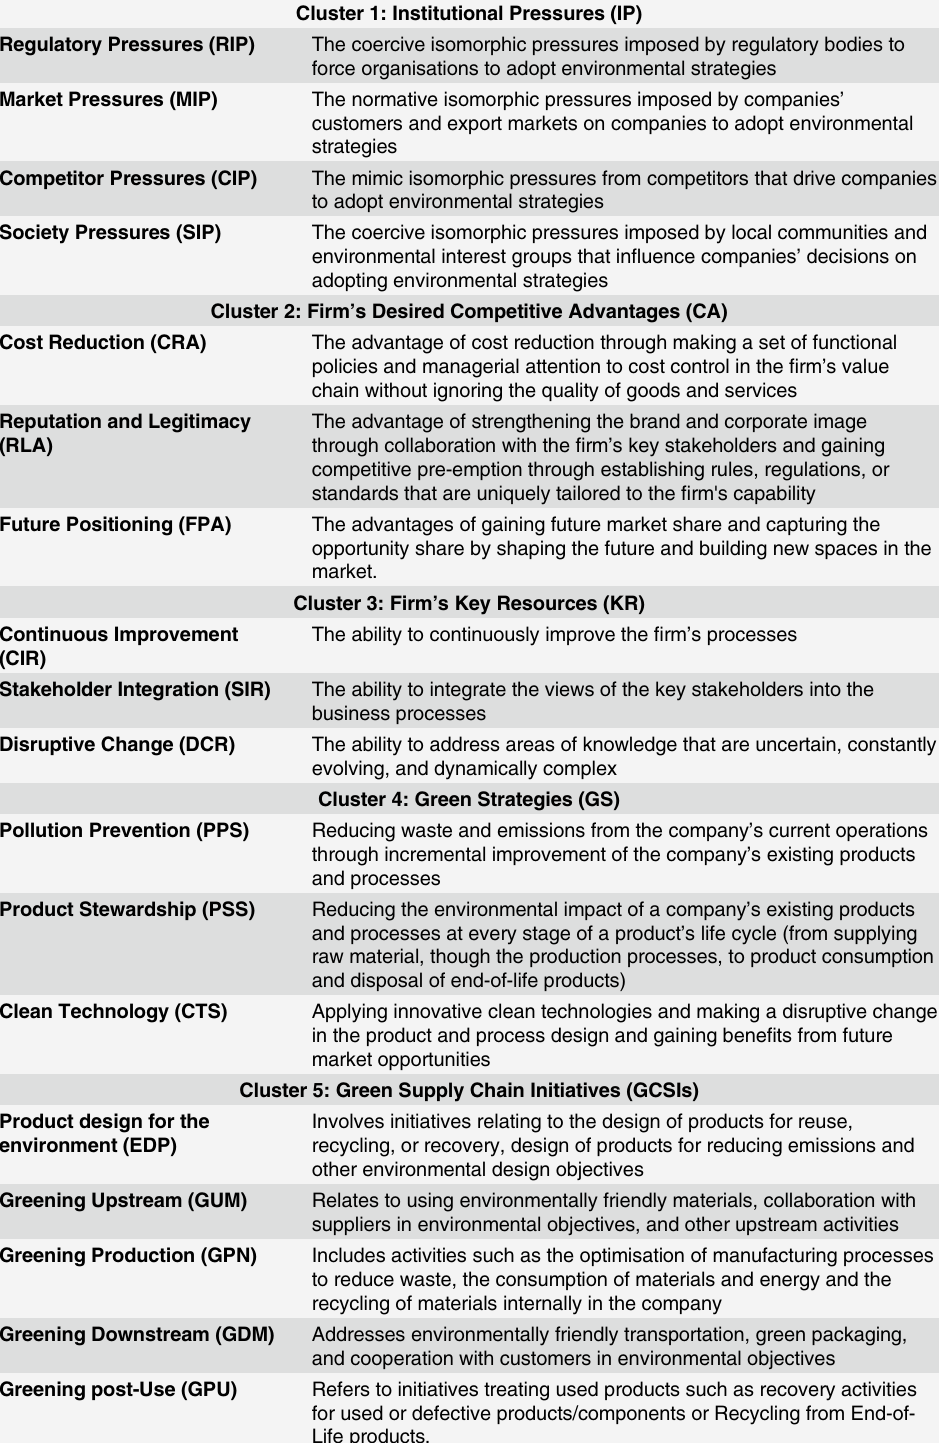
Table 1. Constructs